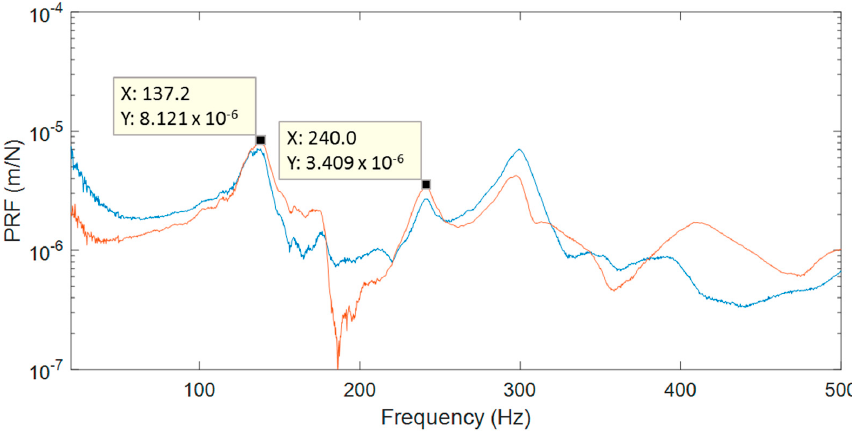
Figure 7. Two principal response functions from impact hammer tests of specimen 2.